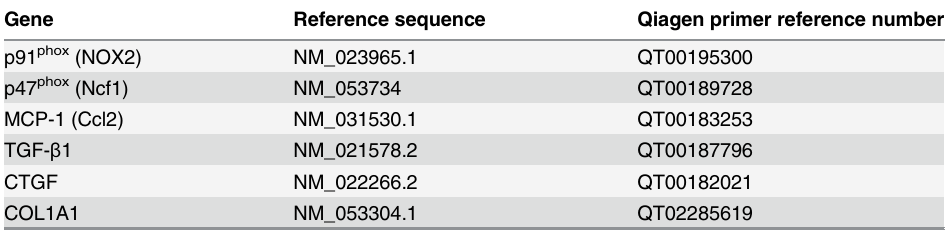
Table 1. Qiagen primer reference numbers.